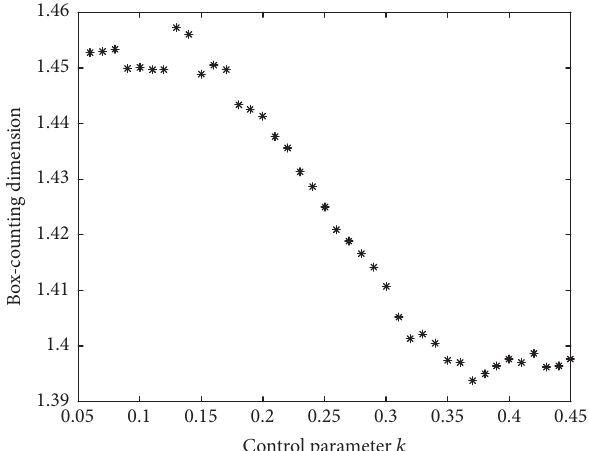
Figure 3: The change of box-counting dimensions of the Julia sets of the controlled system when 𝑘 is from 0.06 to